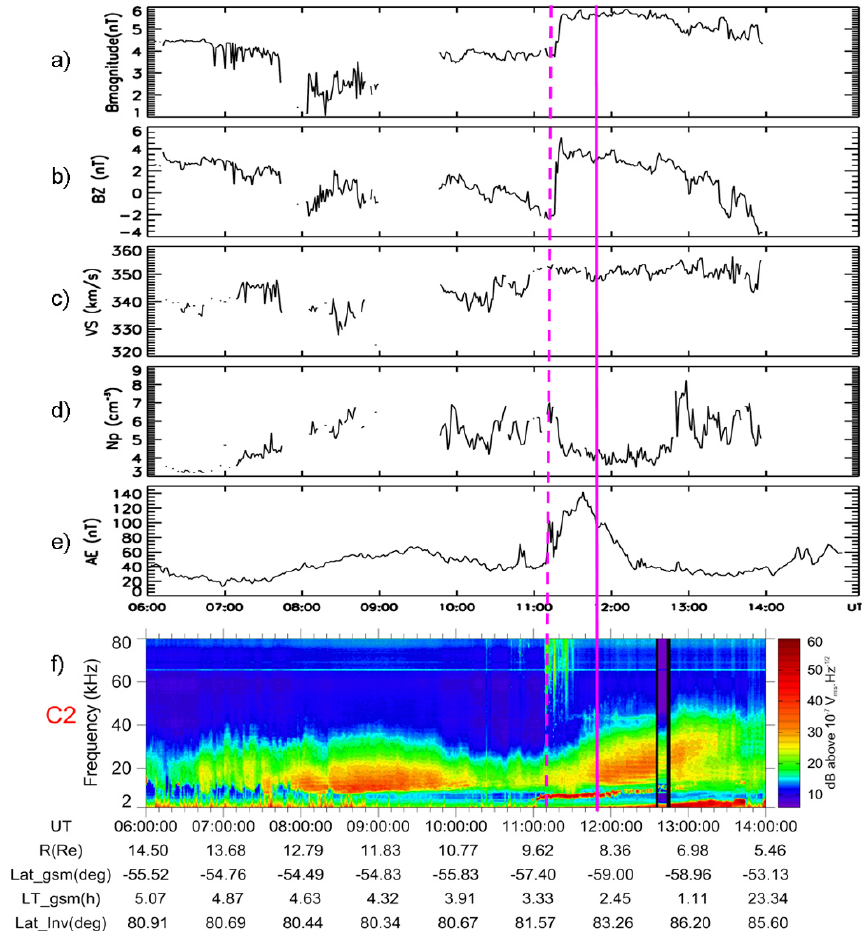
Fig. 10. Evolution of interplanetary and auroral parameters (panels a - e ), and of radio emissions observed by WHISPER on board C2 (panel f ), on 18 May 2008, from 06:00 to 14:00UTC. A dashed line (at ∼ 11:10UTC) points to a change in geophysical conditions. A solid line (at ∼ 11:50UTC) indicates the start time of prominent NTC emissions studied (Fig. 6). According to the global shape of the spectral signature displayed, they belong to a NTC enhancement (see text). The apparent anomaly during the interval 12:37–12:43UTC (sudden lowering of global intensity) is due to using the E z dipole antenna instead of the E y dipole antenna. The E z dipole having lost a sensor, its effective length has been divided by a factor